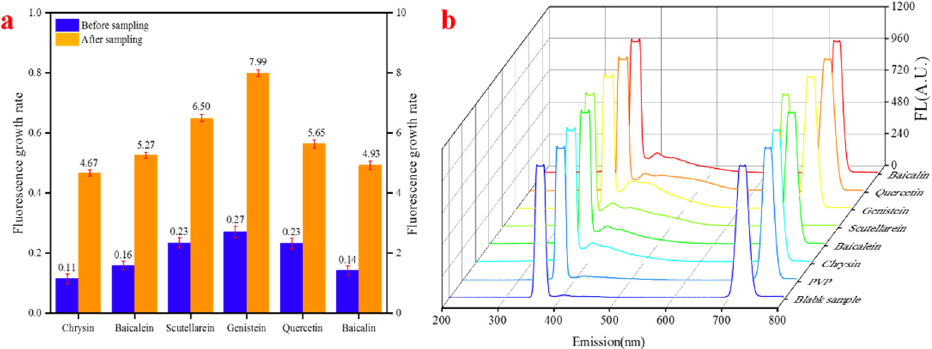
Figure 6 . Fluorescence and fluorescence enhancement in the active molecular membrane trap cham- ber after simulated OH radical reaction ( a ) Fluorescence enhancement graph, ( b ) Fluorescence spectrum graph.